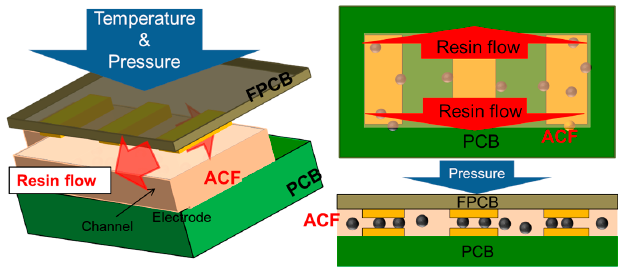
Figure 1. Bonding process and formed flex-on-board interconnection.